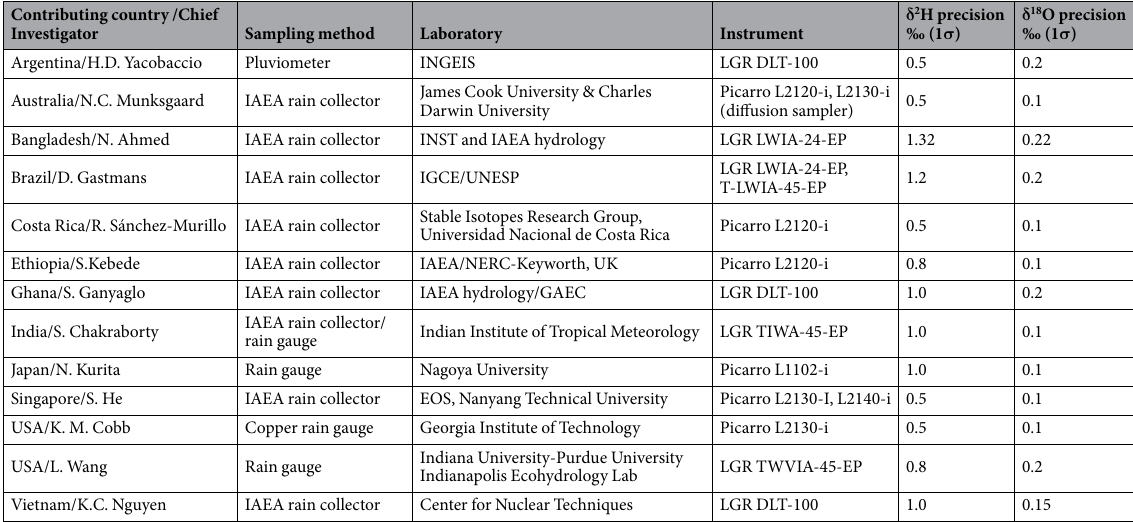
Table 2. Investigator, sampling and analytical information.